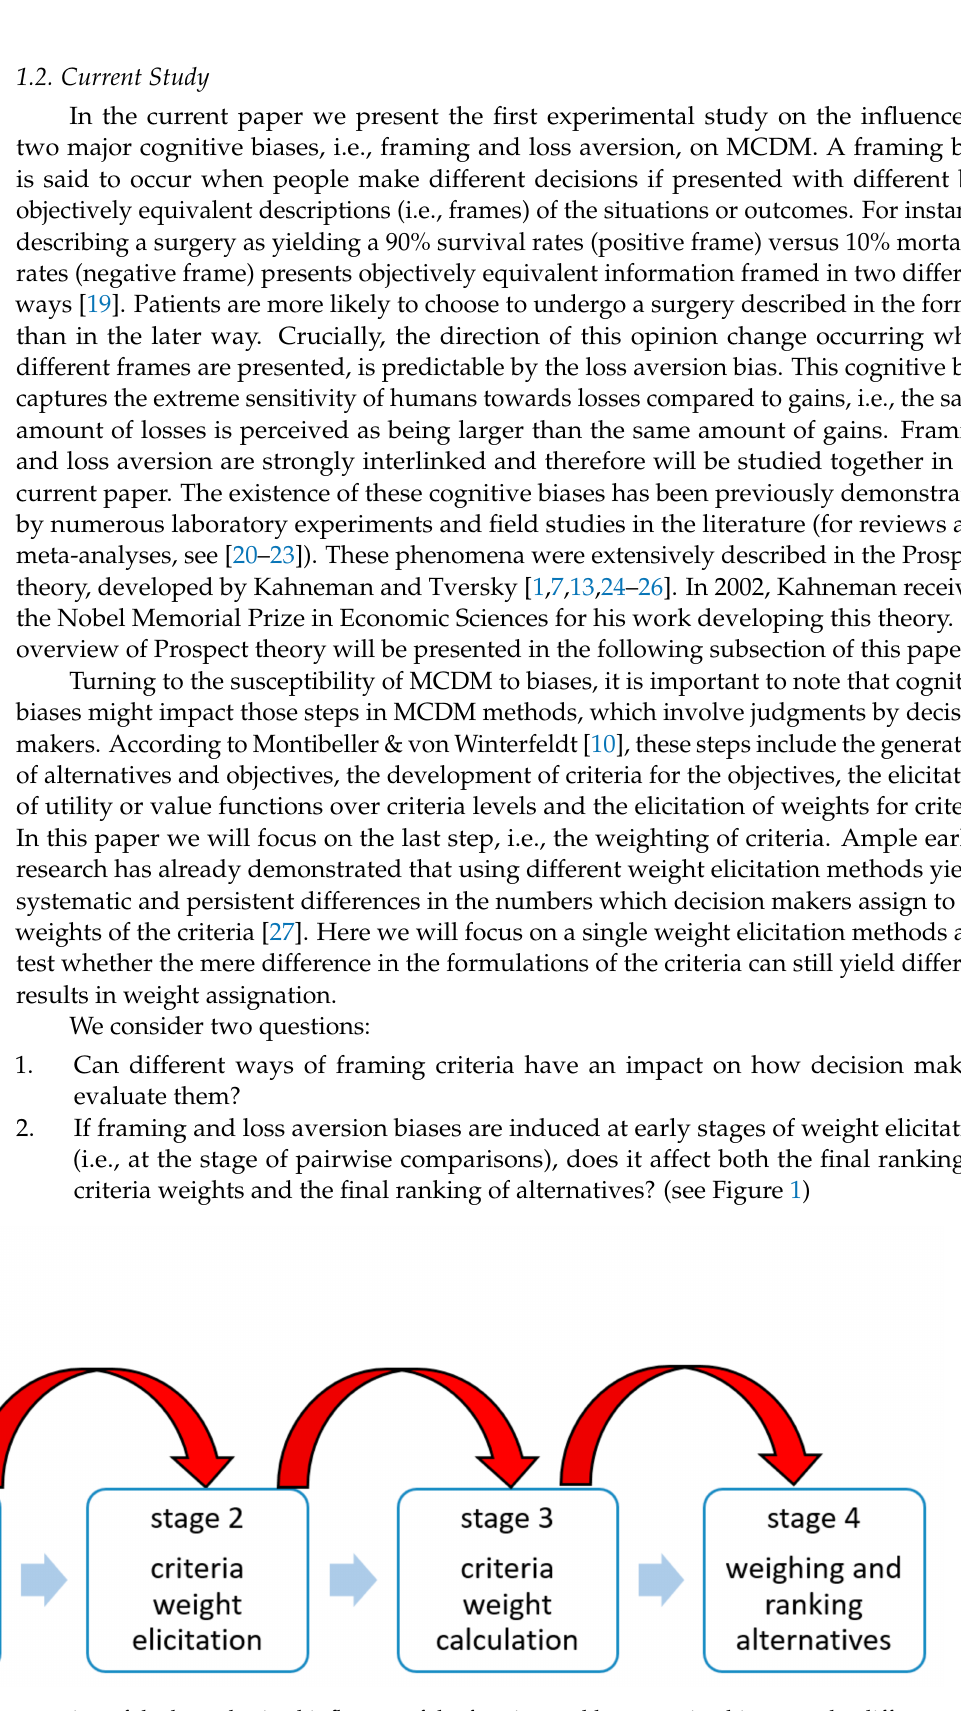
Figure 1. A schematic representation of the hypothesized influence of the framing and loss aversion biases on the different stages of